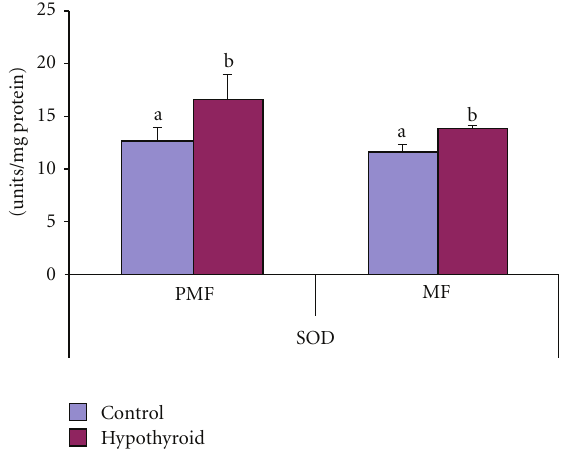
Figure 5: E ff ect of neonatal PTU treatment on superoxide dismu- tase activity (SOD; units/mg protein) in postmitochondrial fraction (PMF) and mitochondrial fraction (MF) of testes of rats. Data are expressed as mean ± S.D. of 5 observations and subjected to unpaired Student’s t -test. Statistical significance was accepted at P < 0 . 05. Control and hypothyroid groups were found to di ff er signifi- cantly at P < 0 . 05 as represented by superscripts of di ff erent letters. Control (Group-I): 30-day-old control rats; hypothyroid (Group- II): 30-day-old rats with PTU treatment from day 1 postpartum to day 30 postpartum.